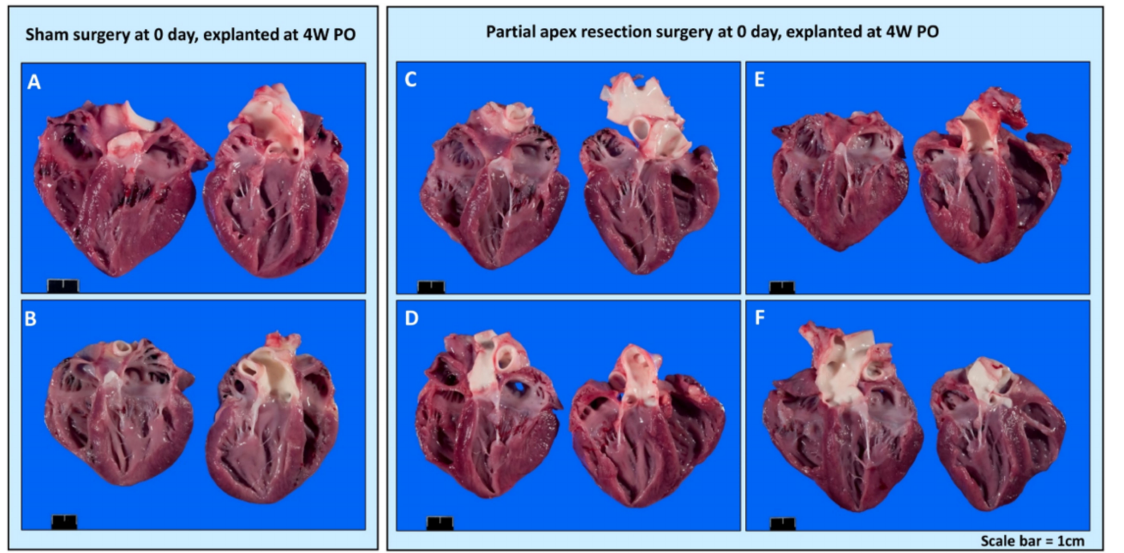
Figure 4. Gross anatomy photos. ( A ) Zero-day control (sham) heart from piglet #2033. ( B ) Zero-day control (sham) heart from piglet #2038. ( C ) Zero-day surgery heart from piglet #2034. ( D ) Zero-day surgery heart from piglet #2035. ( E ) Zero-day surgery heart from piglet #2036. ( F ) Zero-day surgery heart from piglet #2037. Scale bar = 1 cm.